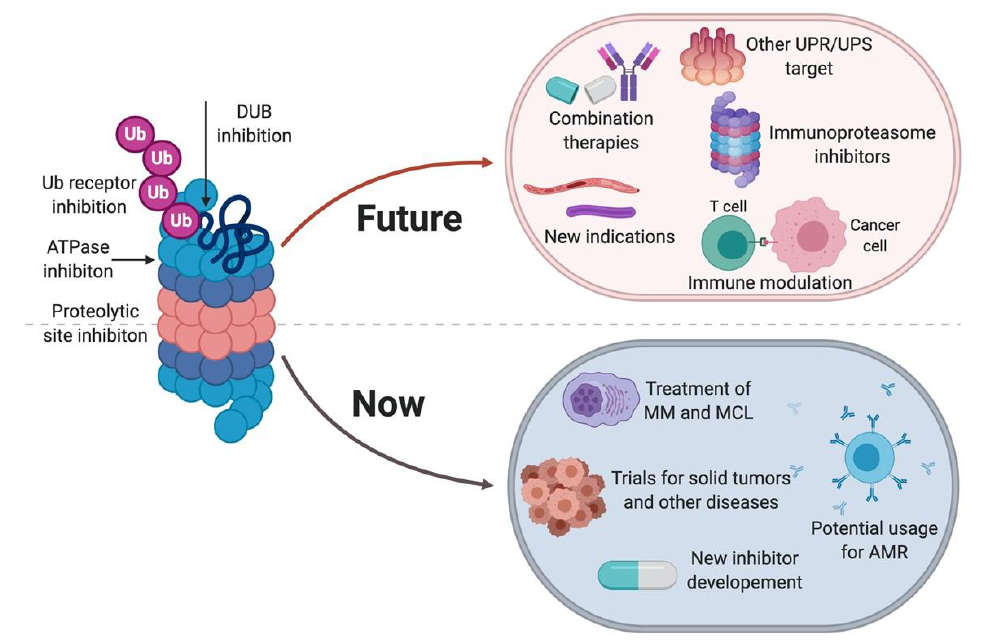
Figure 4. State of proteasome inhibitors, including summary of current state and future of proteasome inhibitors [85].